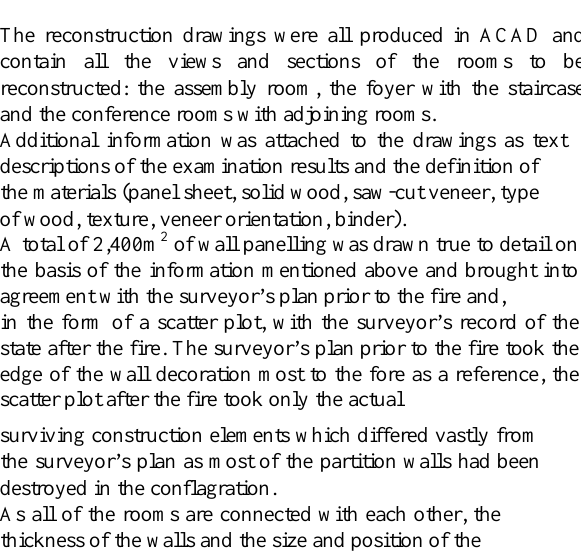
Picture 23: Milled duplication in